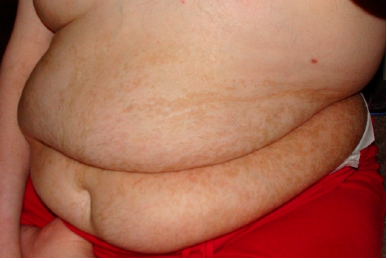
Figure 1. Pigmentary Changes in a Patient with Somatic Mosaicism. Note the linear pattern of the pigmentary changes.